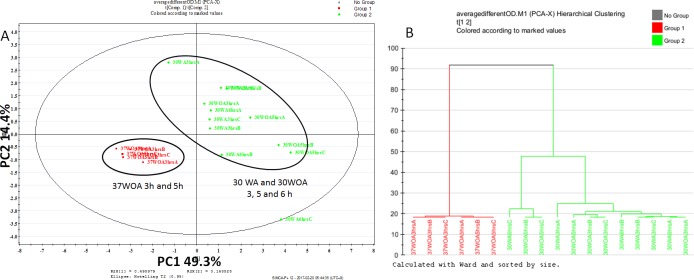
Score plot of PCA (A) and dendrogram (B) of L. lactis at different conditions and different sampling points.All conditions were obtained using 0.5 g/L of unlabeled glucose. Red represents 37 °C without agitation (37WOA), harvested at three and five hours, green represents 30 °C with (30WA) and without agitation (3OWOA) harvested at three, five and six hours of cultivation. Score plot was achieved via two principal components with total variation of 64%. Datasets of PAAs were normalized using D4-alanine for normalization purposes.